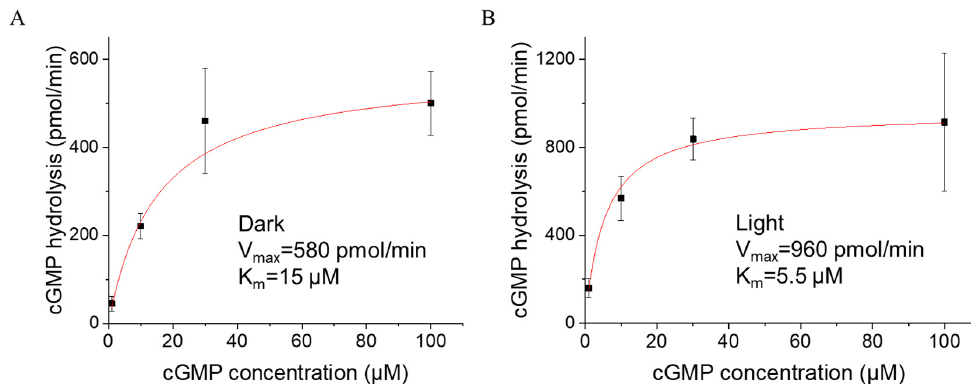
Figure 4. Light altered the substrate binding affinity of YFP:: Cf RhoPDE1. ( A ), cGMP ‐ dependence of YFP:: Cf RhoPDE1 activity in the dark. ( B ), cGMP ‐ dependence of YFP:: Cf RhoPDE1 activity under illumination with 505 nm cyan light at 0.15 mW/mm 2 . For ( A , B ), the data were fitted with the Michaelis–Menten equation. In vitro reactions were started with 1, 10, 30 and 100 μ M cGMP. The final activities were calculated for membrane proteins extracted from one oocyte. n = 4–6, error bars = SD.